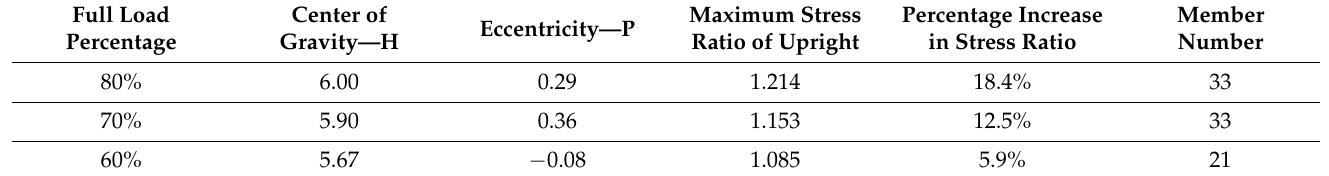
Table 3. Parameters related to the most unfavorable distribution patterns of the optimized loads.